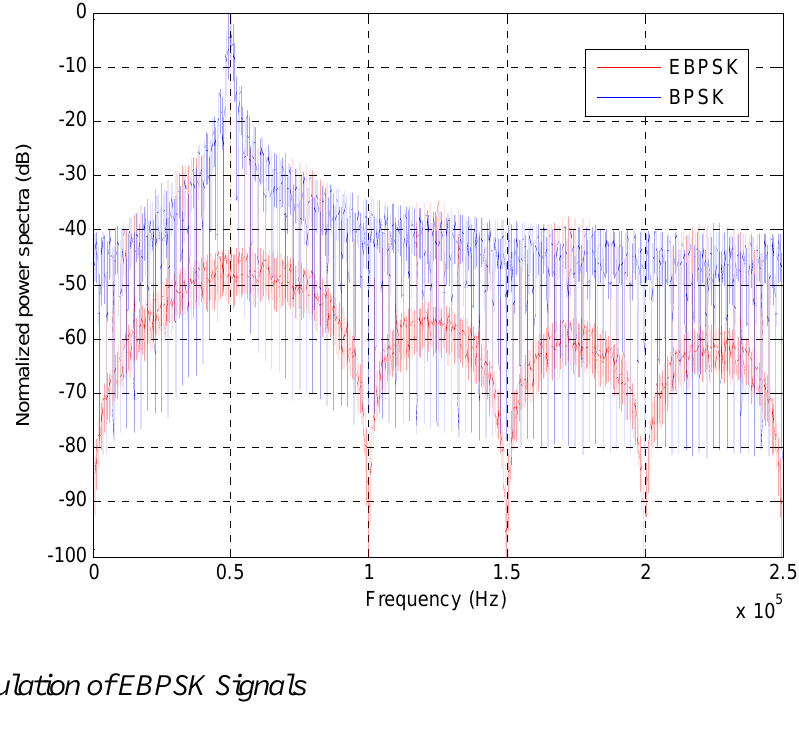
Figure 1. PSD of the BPSK and EBPSK modulations, all carrier peaks are normalized at